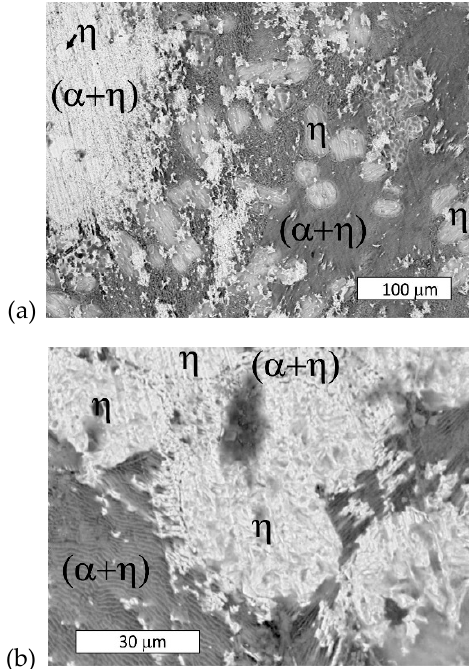
Figure 9. ( a ) SEM image of the surface of a sample after polarization up to a potential of + 225 mV vs. E corr . Selective dissolution of the Zn-4Al alloy is visible. The dark areas represent areas in which the eutectic structure has dissolved. ( b ) Magnified